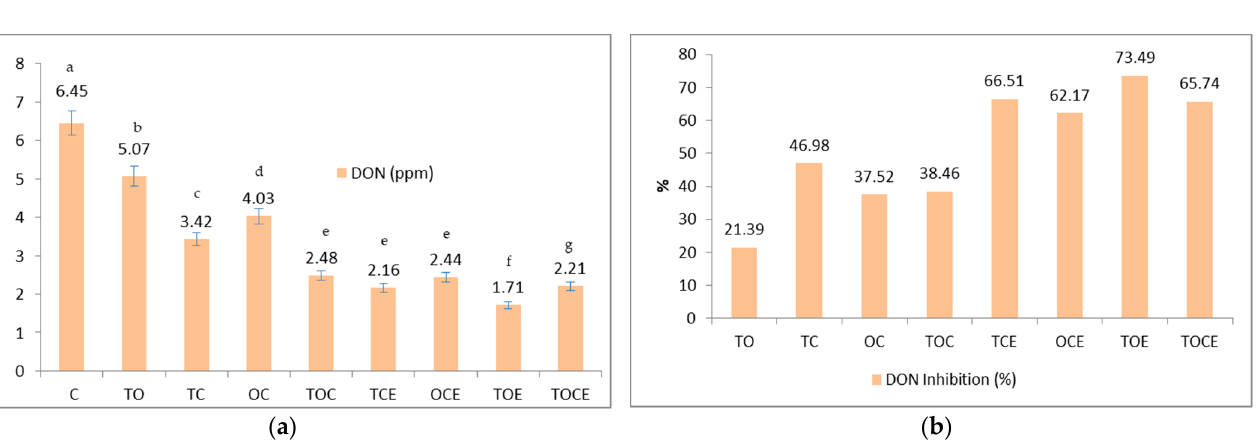
Figure 3. The DON content ( a ) and the percentage of DON inhibition ( b ) after 28 days of treatment with EOs and natural preparations. OC—binary mixture of oregano and coriander EOs; OCE—binary emulsion of oregano and coriander EOs; TO—binary mixture of thyme and oregano EOs; TOE—binary emulsion of thyme and oregano EOs; TC—binary mixture of thyme and coriander EOs; TCE—binary emulsion of thyme and coriander EOs; TOC—tertiary mixture of oregano, coriander, and thyme EOs; TOCE—tertiary emulsion of oregano, coriander, and thyme EOs. The values are expressed as mean values ± standard deviations of all measurements. Different superscripts a–g between samples represents significantly different values ( p < 0.05) according to the t ‐ test; the same superscripts a–g between samples represents not significantly different values ( p > 0.05).